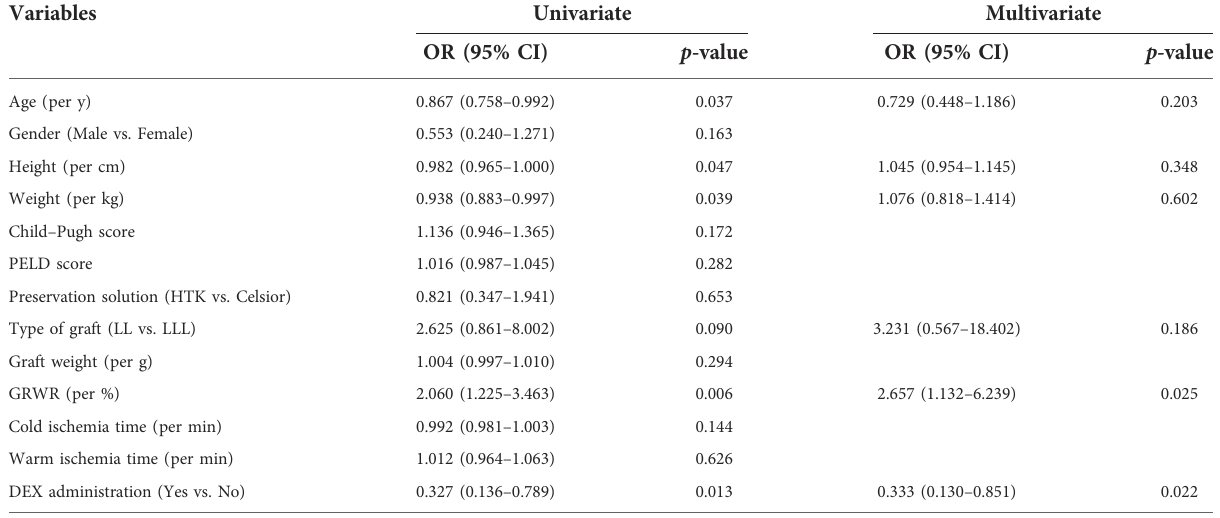
TABLE 3 Univariate and multivariate logistic regression analysis assessing the risk factors for moderate-to-extreme HIRI in pediatric living-related liver transplantation.